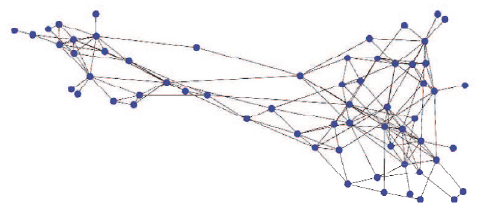
Figure 4: The dolphins